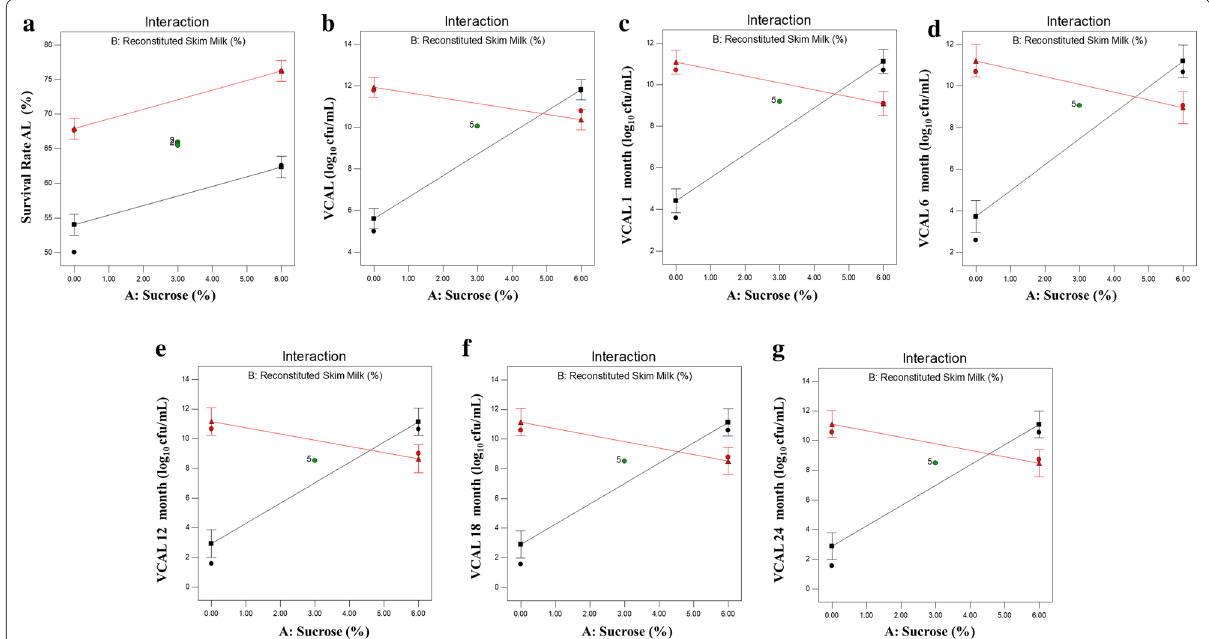
Fig. 3 Interaction of sucrose versus reconstituted skim milk on a Survival Rate (%), log10 CFU/mL values obtained in b Viable count after lyophilization[VCAL], c VCAL 1 month, d VCAL 6 months, e VCAL 12 months, f VCAL 18 months and g VCAL 24 months lyophilized probiotics powder